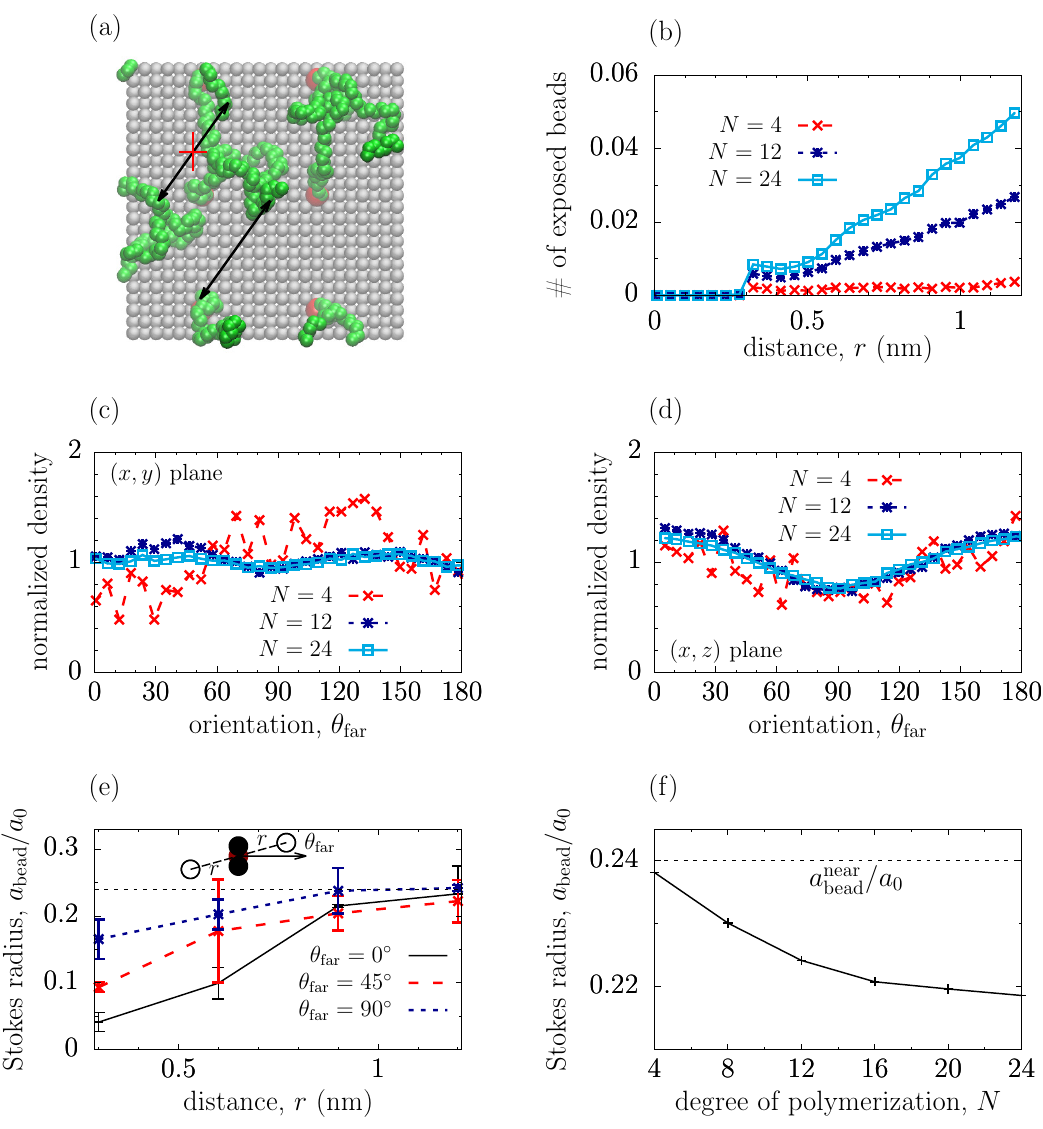
Figure 4. Far bead structure and flow shielding. ( a ) Snapshot from MD simulations showing the top view on the bottom surface. The wall atoms are shown in grey, the polymer beads in green, and the beads attached to the wall are shown in red. The arrows demonstrate the separations between far beads, and the crossed arrow demonstrates the separations not counted in the distribution function shown in panel ( b ); ( b ) Average number of far beads directly exposed to each other (see text) in the polymeric coating of Figure 1a as a function of separations between the beads; ( c,d ) Orientation distribution of far beads in the polymeric coating calculated in the ( x , z ) and ( x , y ) planes (see Figure 1a) for different degrees of polymerization, N . The density is normalized to the average density at given N ; ( e ) Screening of the central bead of a three-bead complex by two far beads located symmetrically around the complex (see the sketch); ( f ) Hydrodynamic radius of the central bead of the complex as a function of the degree of polymerization calculated by using Equation (2). In ( e , f ), the horizontal dash lines denote the value of the hydrodynamic radius a near due to shielding by near beads only; a bead is bead expressed in terms of the physical radius a 0 = 0.153 nm. Compare with Figure